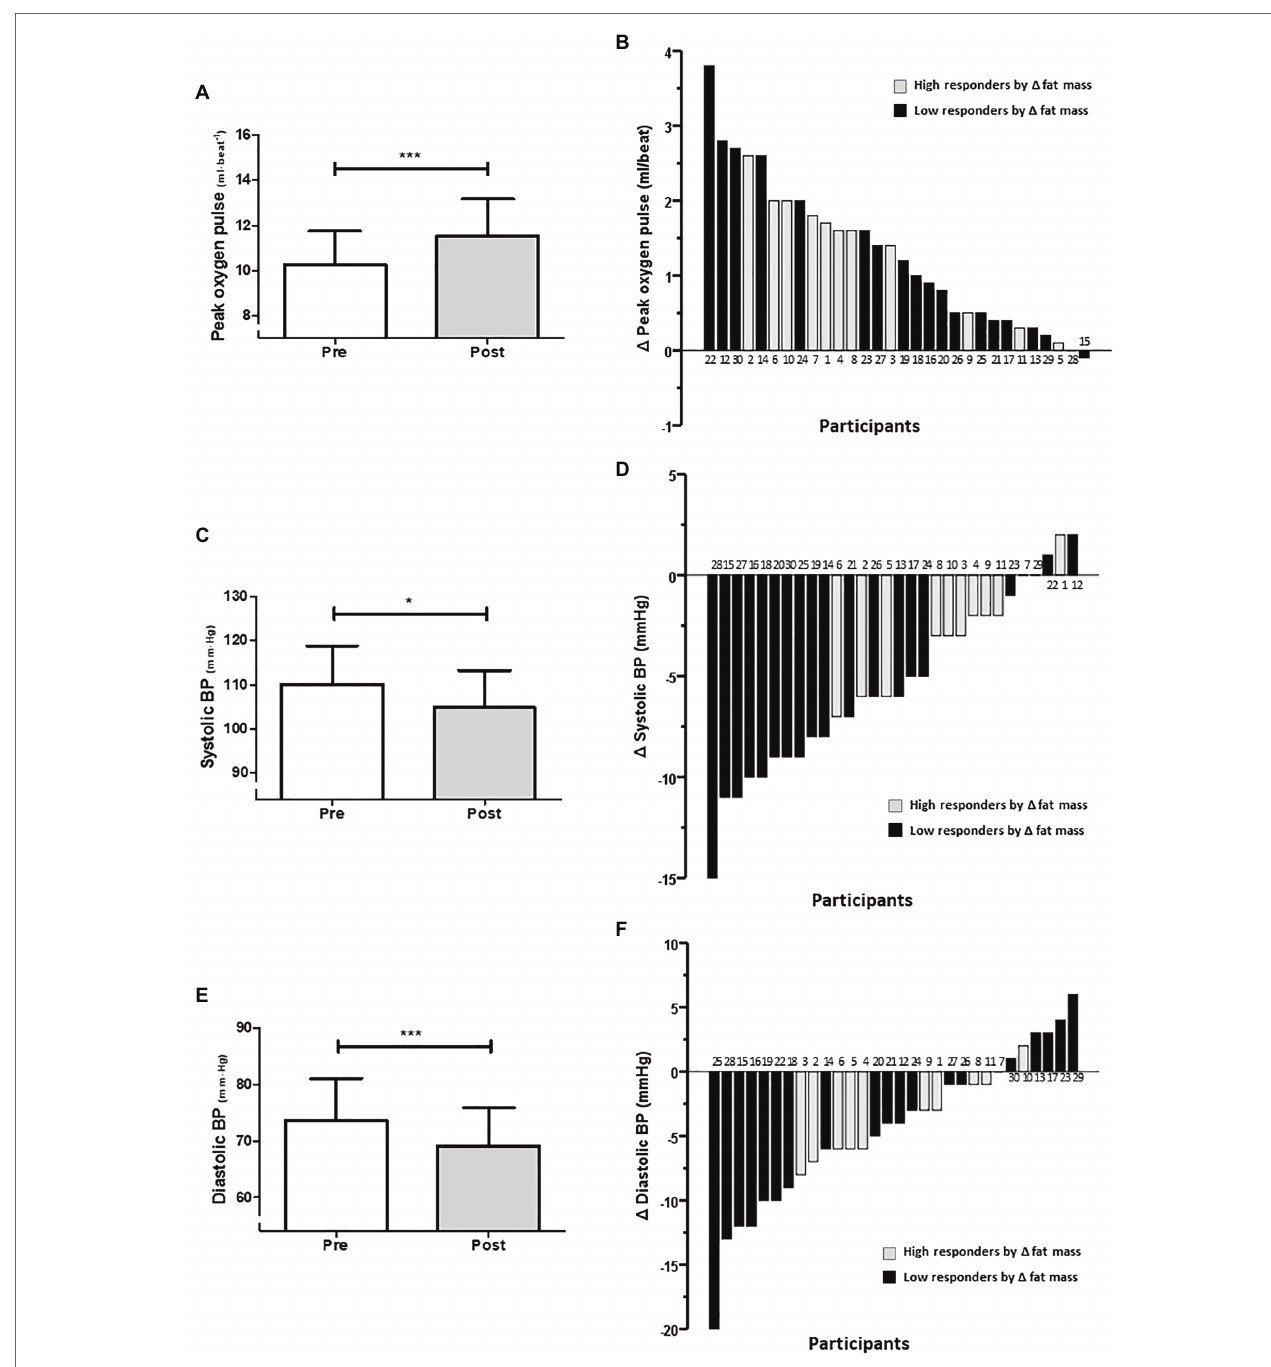
FIGURE 5 | Average changes (A,C,E) and individual response (B,D,F) in cardiovascular outcomes after 12-week intervention [ A,B : peak oxygen pulse; C,D : systolic blood pressure (SBP); and E,F : diastolic blood pressure (DBP)]. Numbers above and below the bars (B,D,F) represent the order of magnitude in the individual response to reduce fat mass. High and low responders are identified in relation to the ability to reduce fat mass. *** p < 0.0001; * p <